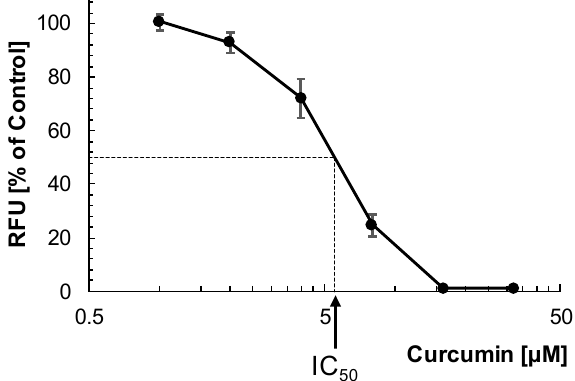
This finding confirmed that curcumin is indeed a non ‐ competitive inhibitor of rhodesain.